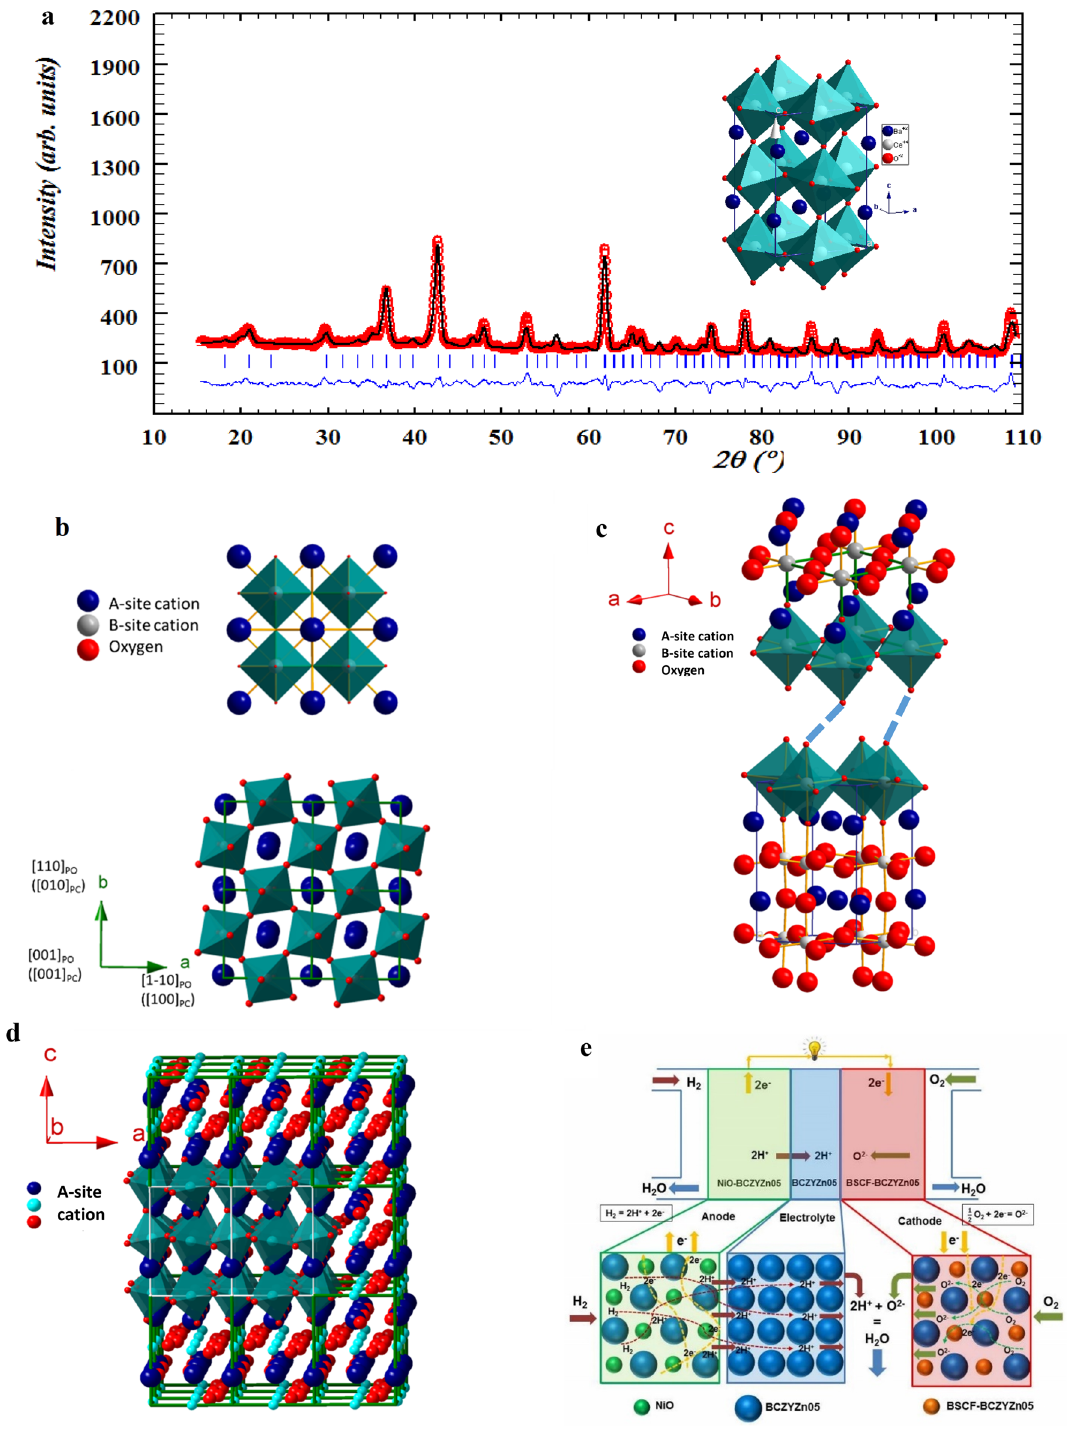
Figure 1. Crystal structure determination and atomic arrangements. ( a ) Rietveld refinement of the neutron diffraction data of BCZYZn05 polycrystalline ceramic powder in orthorhombic symmetry in the Pbnm space group. The unit cell parameters are related to the ideal primitive cubic perovskite cell as a ≈ √ 2a p , b ≈ √ 2a p and c ≈ 2a p ( a p ≈ 3.96 Å is the unit cell parameter of ideal primitive perovskite). Schematic 3D structure is shown in insert. ( b ) c-axis view of cubic (space group Pm-3m ) BSCF cathode and orthorhombic BCZYZn05 electrolyte. In Glazer’s notation, the rotation of oxygen octahedra in this cubic and orthorhombic space group can be described as a 0 a 0 a 0 and a − a − c + , respectively. In the orthorhombic case, the rotation is in-phase around the [001] po axis and out-of-phase around the [1–10] po axis, which indicates that the octahedral distortion in the BCZYZn05 structure will be visual along the [001] po direction. ( c ) The dotted line represents the mismatch between the cubic and pseudocubic (orthorhombic) structures. ( d ) When the same material was used in the cathode|electrolyte|anode, no shifts of the oxygen atoms in the interface occurred, and the arrangement created a strong structural backbone for solid oxide fuel cells. ( e ) Schematic diagram of the all-protonic cell, which shows the proton conducting path and formation of water at the cathode side. Atomic structure of anode, electrolyte and cathode is shown in the lower part. NiO and Ba 0.5 Sr 0.5 Co 0.8 Fe 0.2 O 3 powders were mixed with BCZYZn05 electrolyte powder to make anode and cathode,